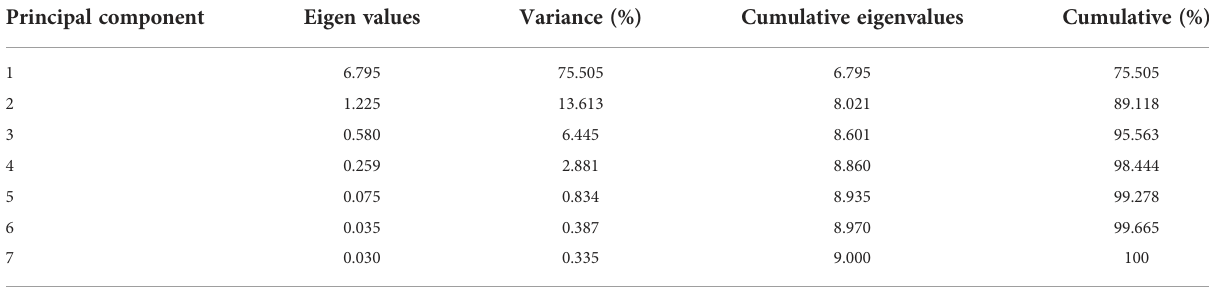
TABLE 4 Principal component analysis, eigenvalues and variance.